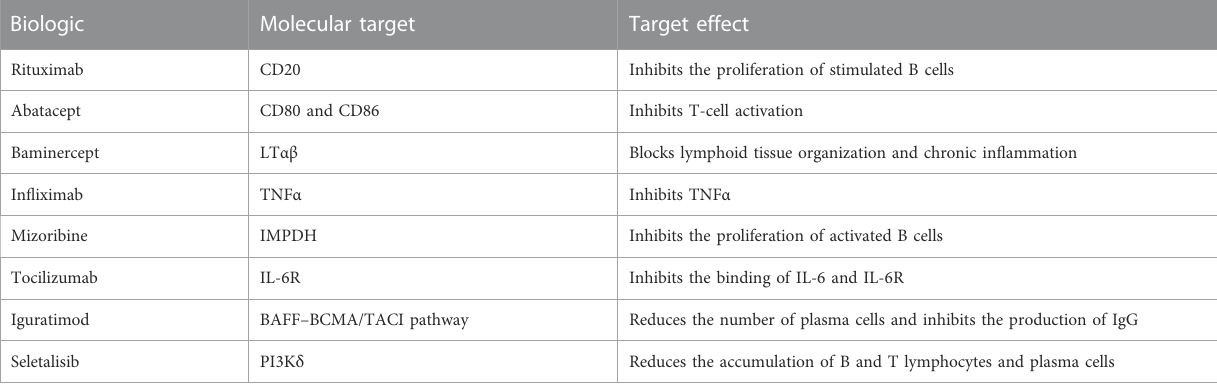
TABLE 1 Molecular target of included biologics trials in pSS.